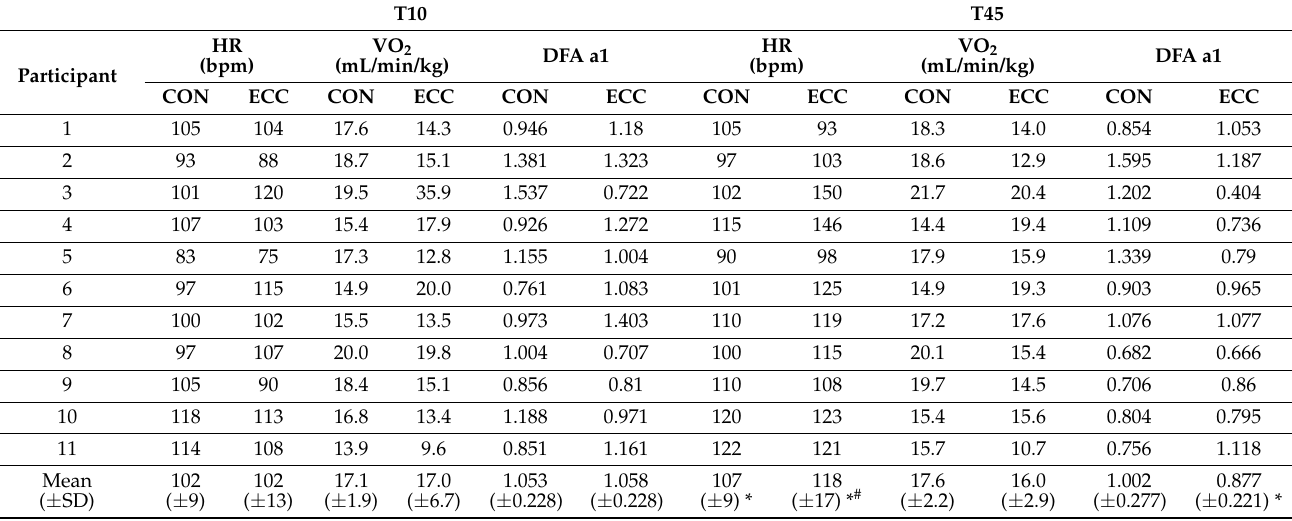
Table 1. Heart rate (HR), oxygen consumption (VO 2 ), and DFA a1 for all participants measured at elapsed time of 10 (T10) and 45 (T45) minutes of either concentric (CON) or eccentric (ECC) cycling. Mean ( ± standard deviation, SD) listed. * Significantly different from T10; # significantly different from